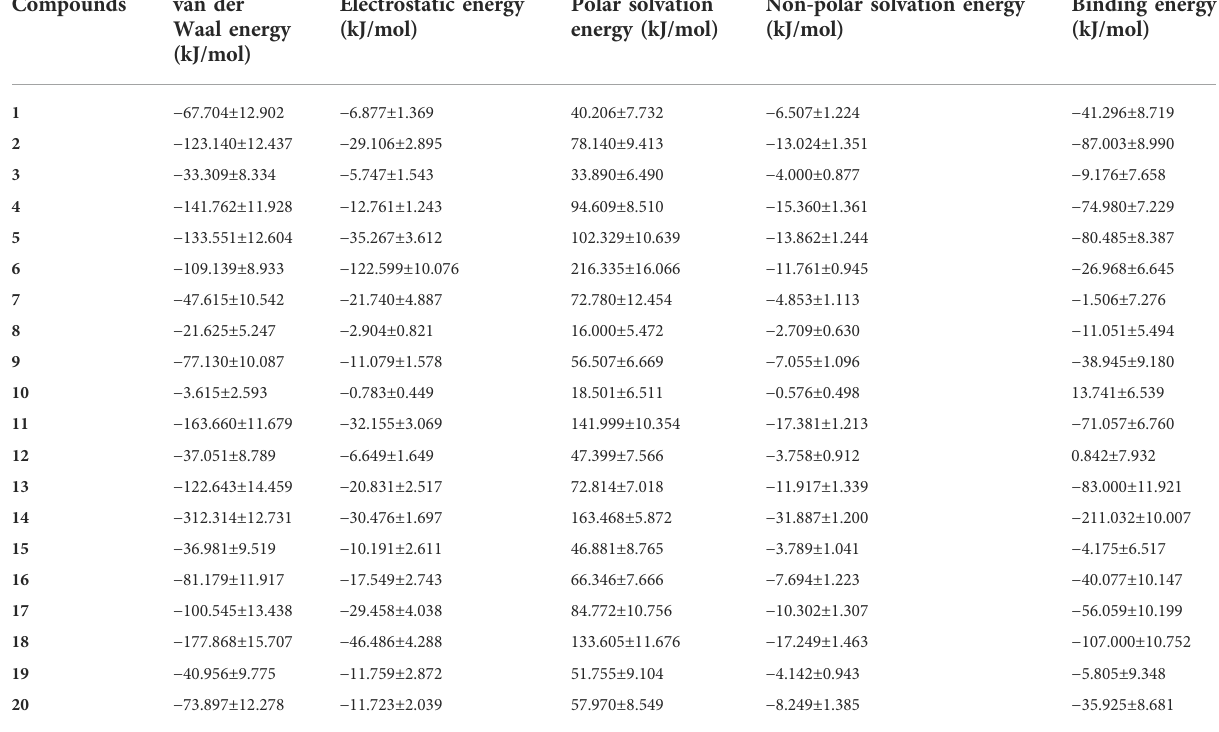
TABLE 4 Binding free energy calculation between the COVID-19 M pro and the top 20 compounds screened by normalized assessment.